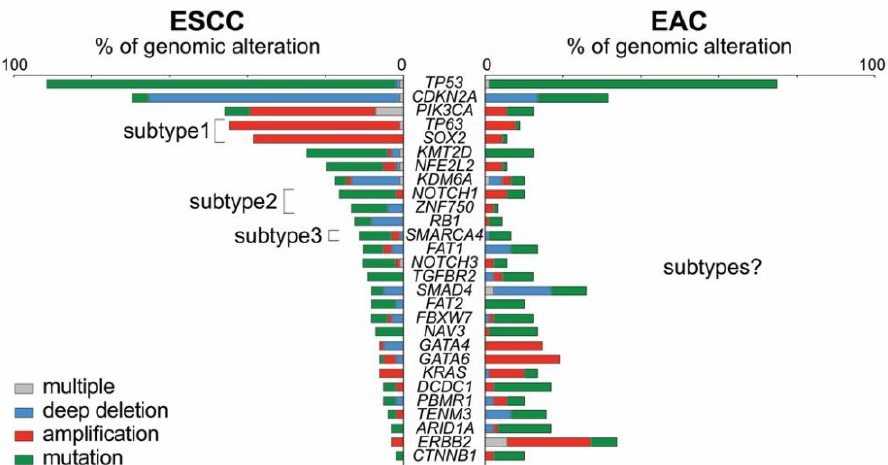
Figure 1. Barplot summarizing frequent genomic alterations found in ESCC and EAC (only alterations >10% of samples in at least one histology are represented). These data highlight differences in the pattern of genomic alterations between ESCC and EAC. Three ESCC molecular subtypes are defined based on the genomic alteration profile. Data from the TCGA, Firehose Legacy ( n = 186).